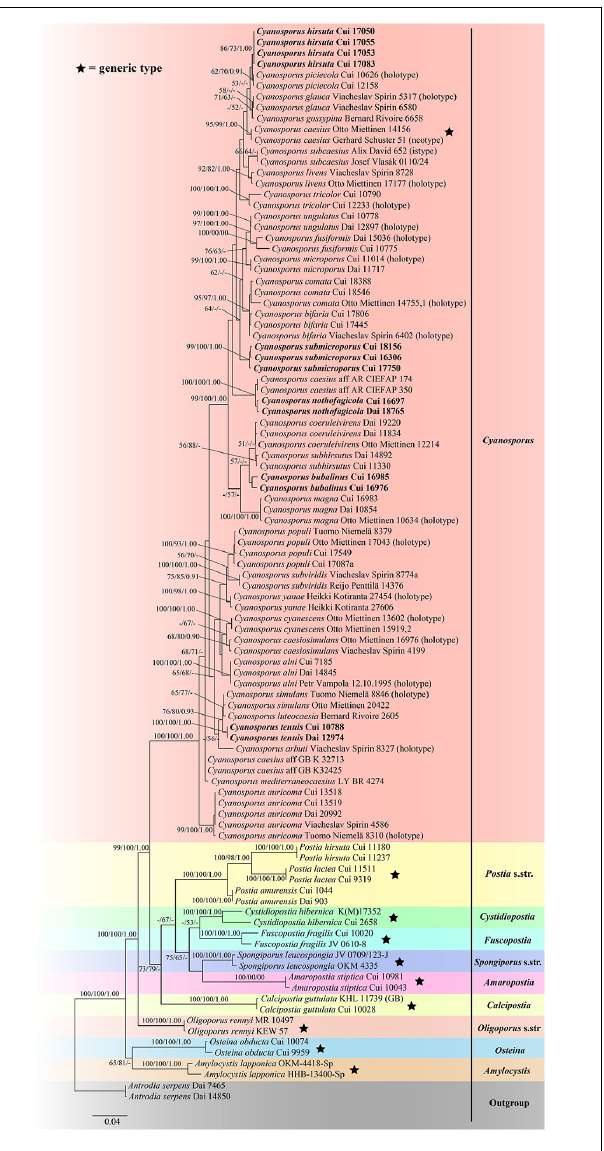
FIGURE 2 | Maximum likelihood tree illustrating the phylogeny of Cyanosporus and its related genera in the antrodia clade based on the combined sequences dataset of ITS + nLSU + TEF. Branches are labeled with maximum likelihood bootstrap higher than 50%, parsimony bootstrap proportions higher than 50% and Bayesian posterior probabilities more than 0.90 respectively. Bold names = New